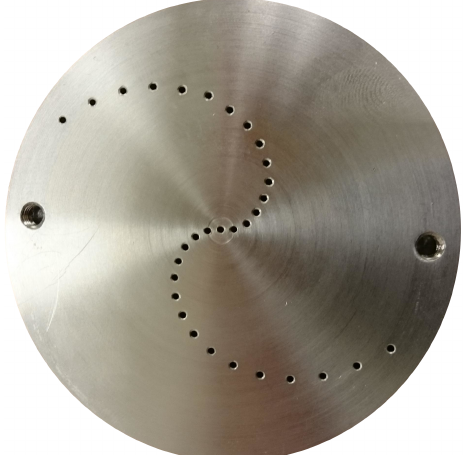
Figure 6. Photograph of the aperture placed in the beamline upstream of the Gabor lens. 30 holes of 2 mm width are drilled in a symmetrical pattern around one further hole on the axis. The surrounding holes are pitched at an angle of 20 ◦